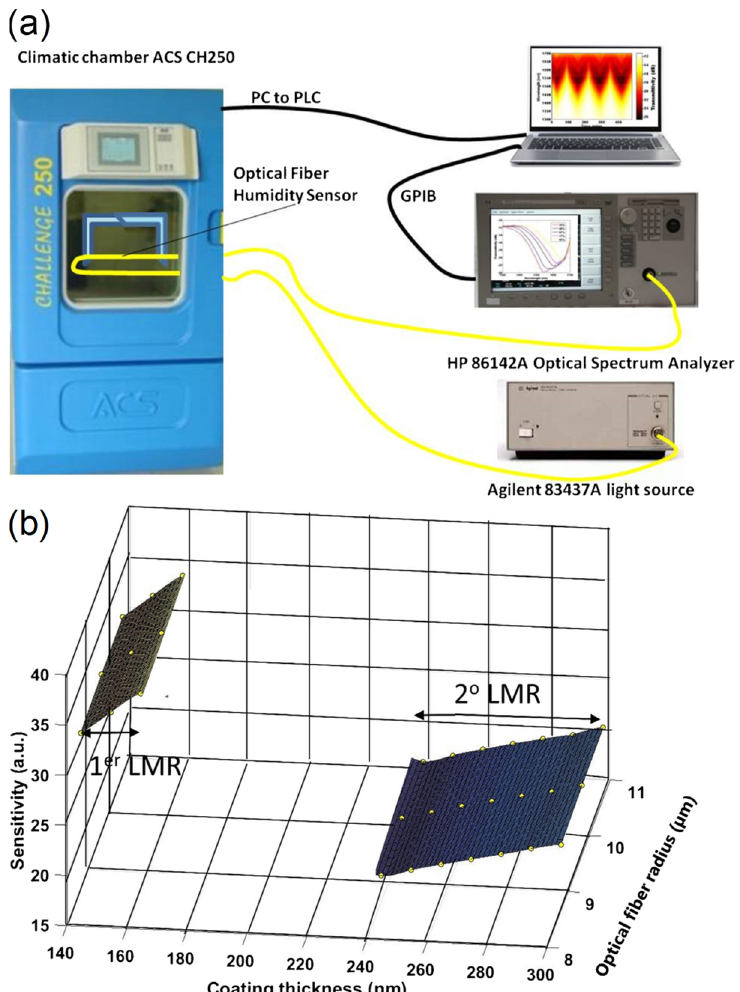
Figure 23. Point sensor. ( a ) Experimental setup. ( b ) Simulated sensitivity as a function of different diameters. Adapted with permission from ref. [111]. Copyright 2016 Elsevier